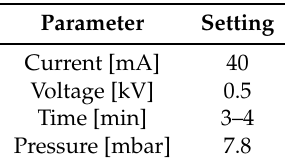
Table 2. Settings used when coating the specimen with